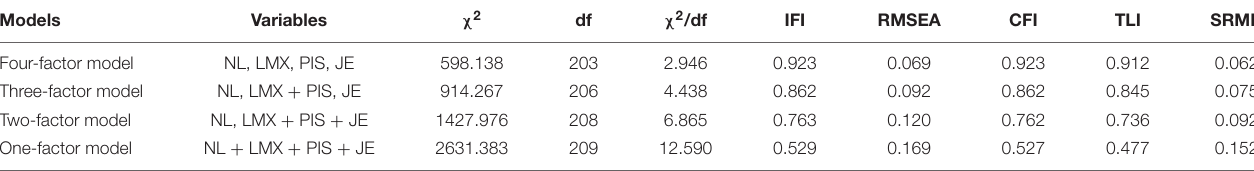
TABLE 2 | Results of correlation